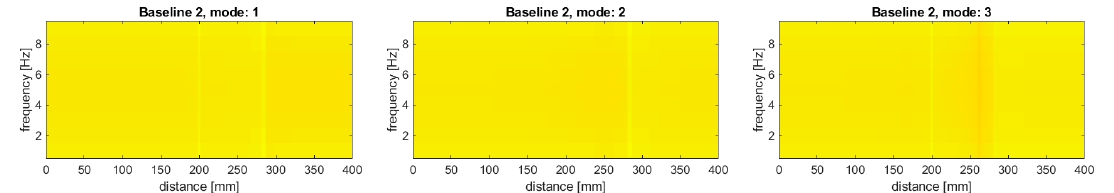
Figure 8. The results of the damage identification using modal displacements as the input data for the considered approaches.